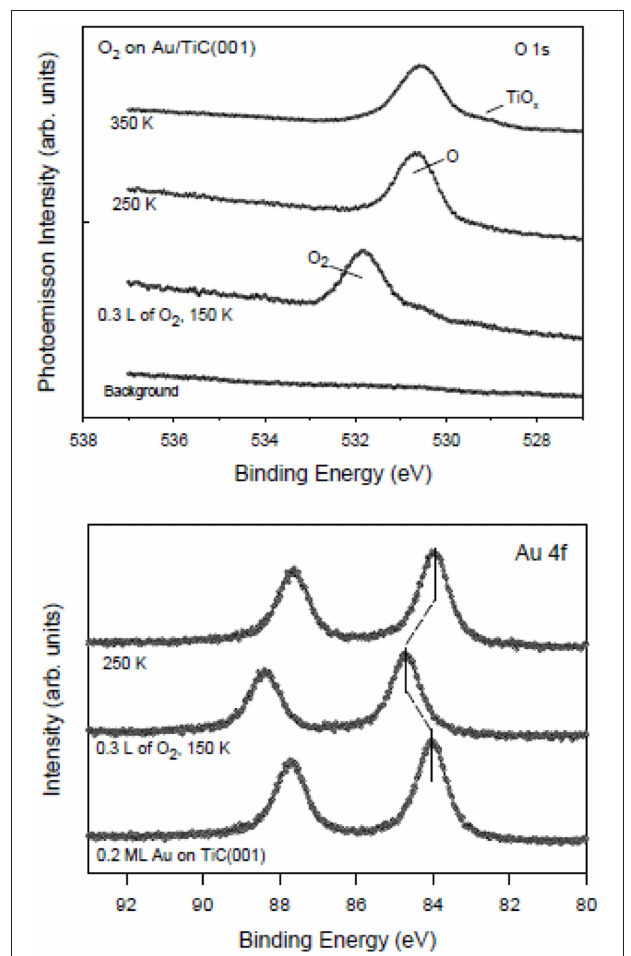
FIGURE 2 | Results of XPS, O 1s (top panel) and Au 4f regions (bottom panel), collected after dosing O 2 to a TiC(001) substrate with 0.2ML of gold. The initial dosing of molecular O 2 was done at 150K. Then, the O 2 /Au/TiC(001) surface was annealed to 250 and 350K. Reproduced with permission